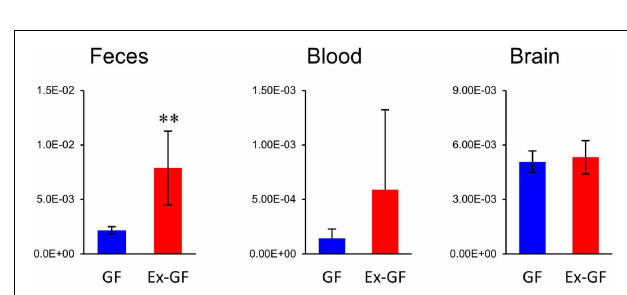
FIGURE 8 | Relative quantitative comparisons of GABA in colonic lumen content, cardiac plasma, and the cerebrum . Data are represented as mean ± SD. ** p <